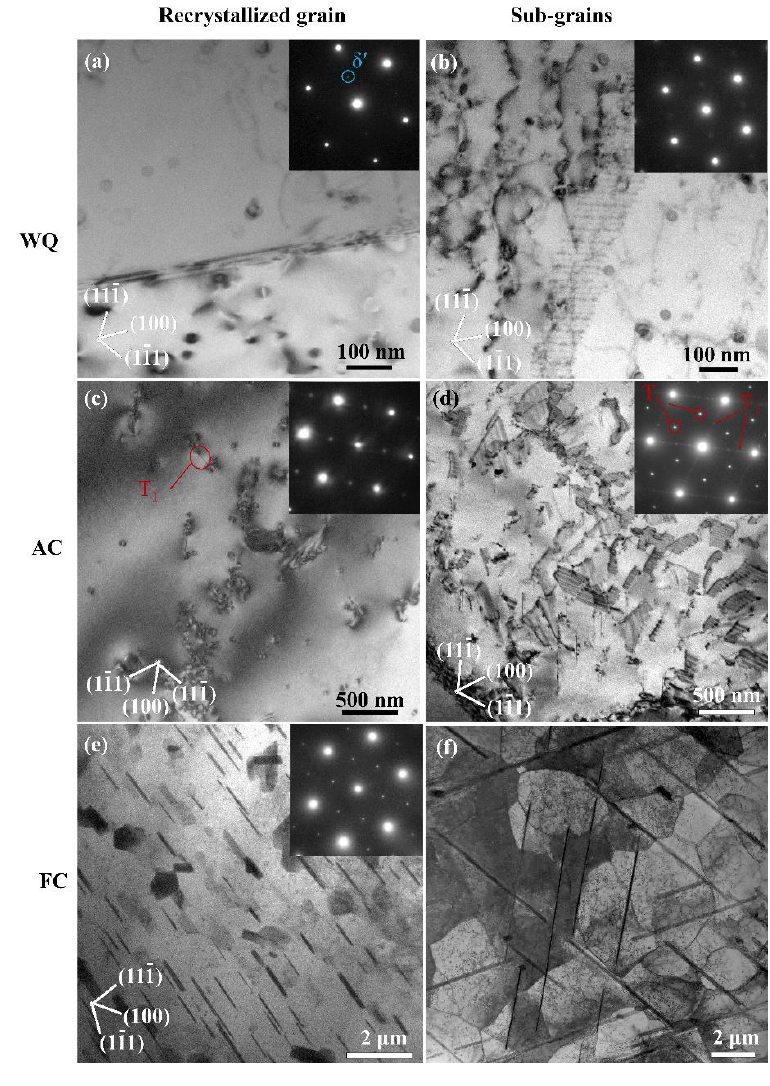
Figure 3. TEM images of the precipitates in recrystallized and sub-grains in 2A97 alloy that scheme 520 °C for 1 h and cooled by WQ, AC and FC: precipitates in recrystallized grain of ( a ) WQ, ( c ) AC and ( e ) FC; precipitates in sub-grains of ( b ) WQ, ( d ) AC and ( f ) FC.